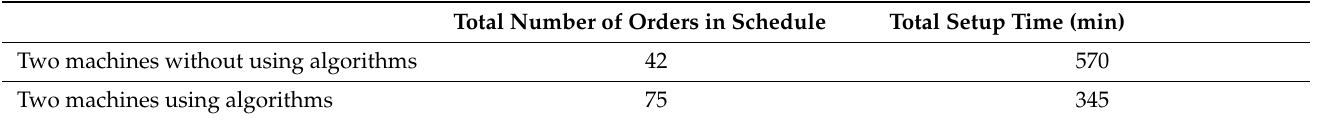
Figure 10. The performance of the total number of orders for each machine.